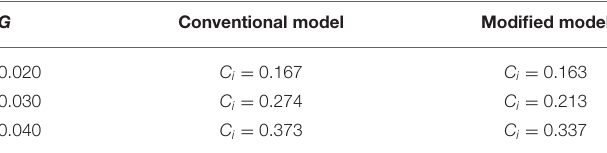
simulations on PTP configurations compared with the conventional model.